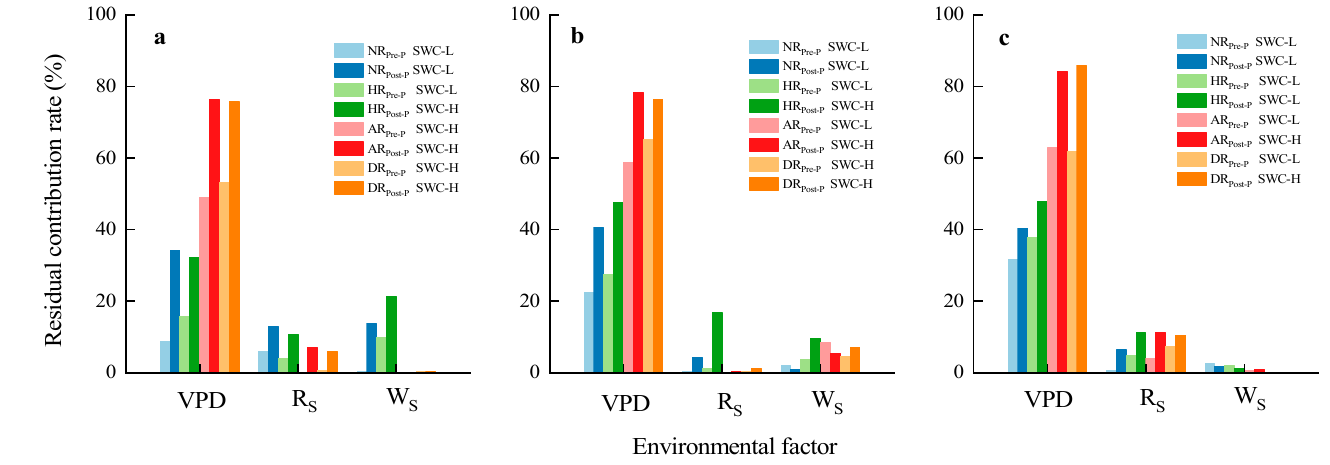
Figure 12. Results of sap flow density and environmental factors of P. orientalis under four water control treatments before and after three rainfall events. ( a ), Precipitation event on September 14. ( b ), Precipitation event on August 19. ( c ), Precipitation event on September 19. Table 3. Effects of environmental factors on sap flow density of P. orientalis under four treatments before and after three rainfall events.